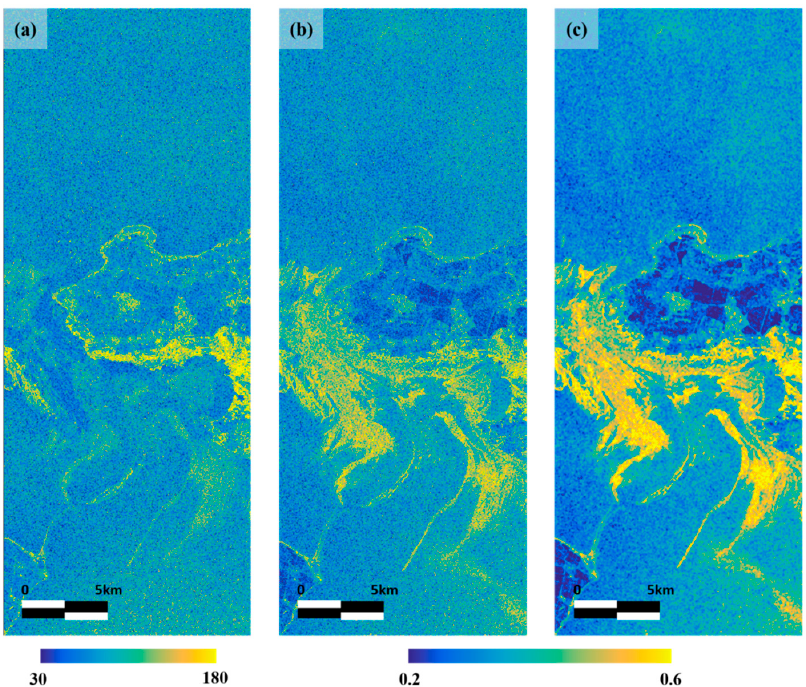
Figure 5. Generation of normalized intensity texture map. ( a ) Texture map is generated by applying the sum of square to difference image which is made by subtracting non-means filtered image from NL-means filtered image; ( b ) Normalized intensity texture map by using NL-means filtered image; ( c ) Generated final map applying NL-means filter.